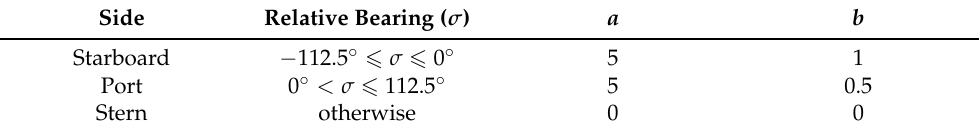
Table 1. Weights a and b depending on the relative bearing, as in Xu et al. [23]. Side Relative Bearing ( σ )